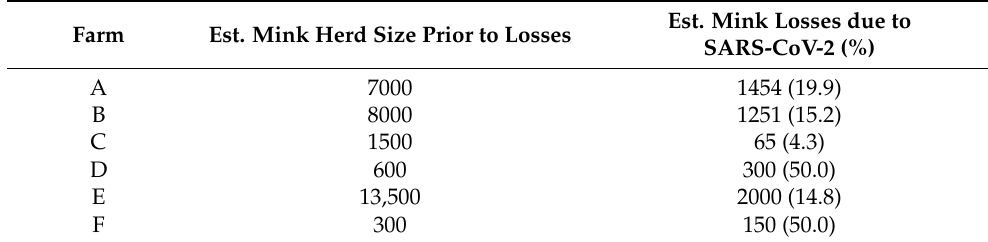
Table 1. Estimated mink herd sizes prior to infection and losses due to SARS-CoV-2 by farm (as reported by farm